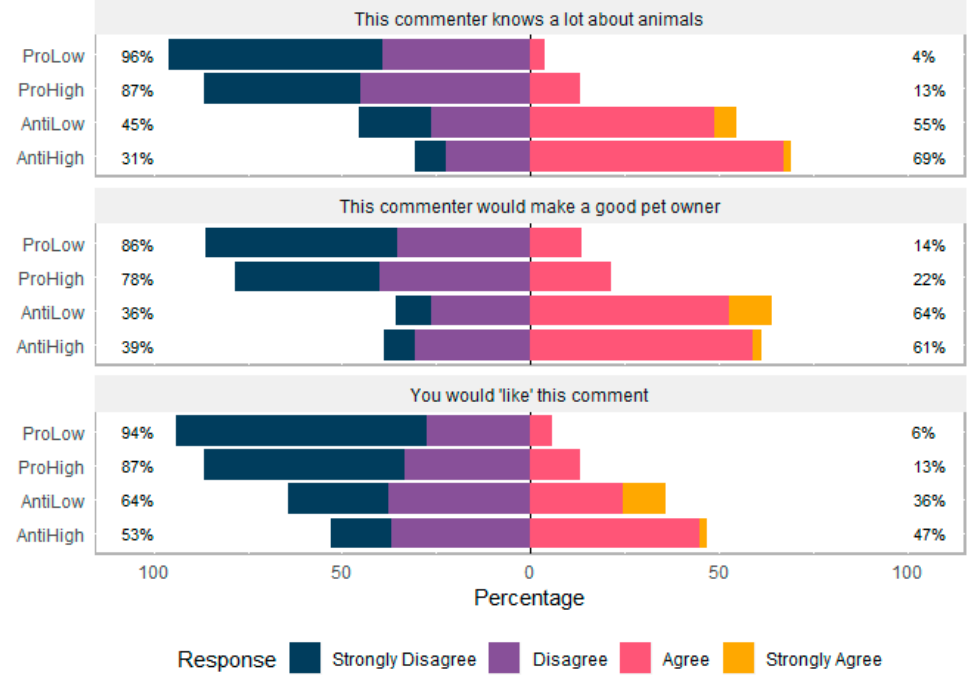
Figure 5. Participants’ (N = 211) agreement with commenter statements discussing primates as pets.